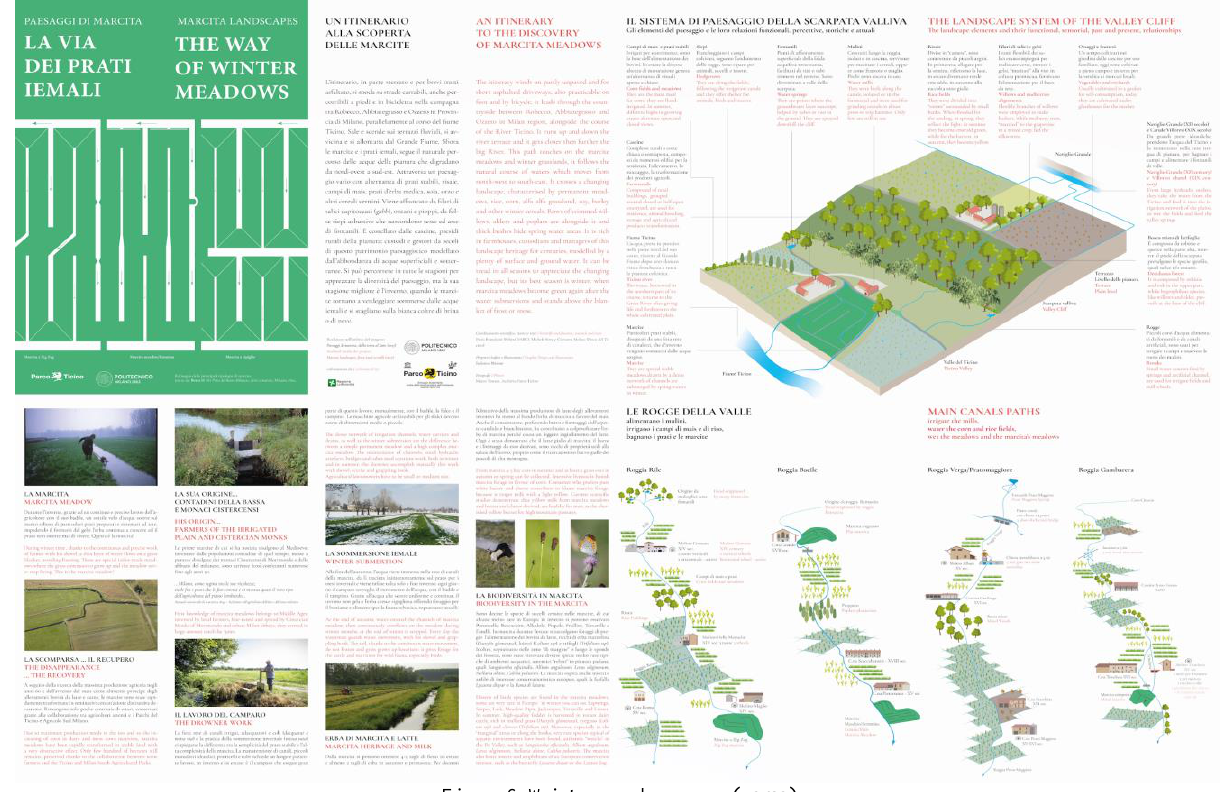
Figura 6. Winter meadows map ( verso